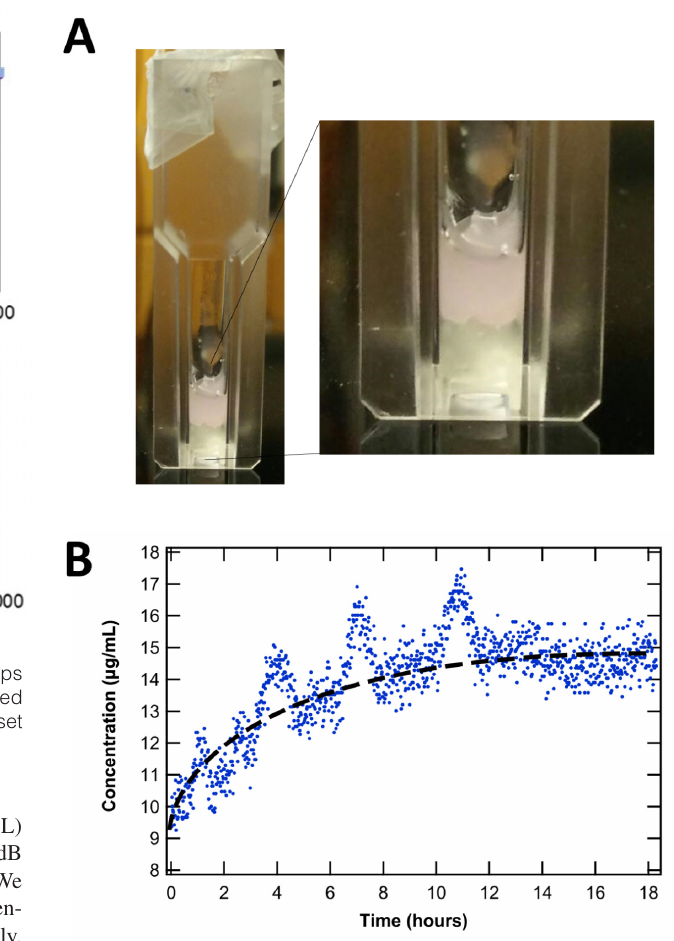
Figure 6. Measuring interfacial mass transfer of a small molecule between hydrophilic and hydrophobic phases. ( A ) Picture of PCL loaded with rhodamine (pink) on top of the HA/CS/BSA blend system, representing the hydrophobic and hydrophilic interface for potential modeling of mass transfer in drug delivery via UV-Vis spectroscopy. ( B ) Concentration at interface after large bolus release over time. Hydrophobic phase drug concentration = 10 µ g/mL. Average hydrophilic phase equilibrium concentration = 14.5 µ g/mL. The periodic fluctuations in concentration were attributed to trapped air interfering with the interface. Dataset 1: UV-Vis data.